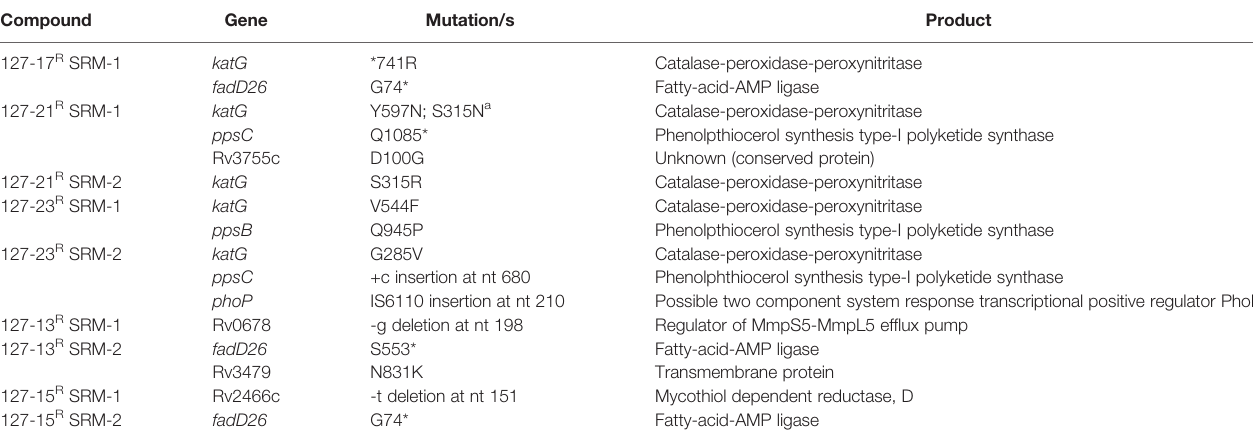
*stop codon; nt, nucleotide. a Since these sites were heterogeneous, 127-21 R SRM-1 was probably a mixture of 2 mutants, each with a different KatG mutation.